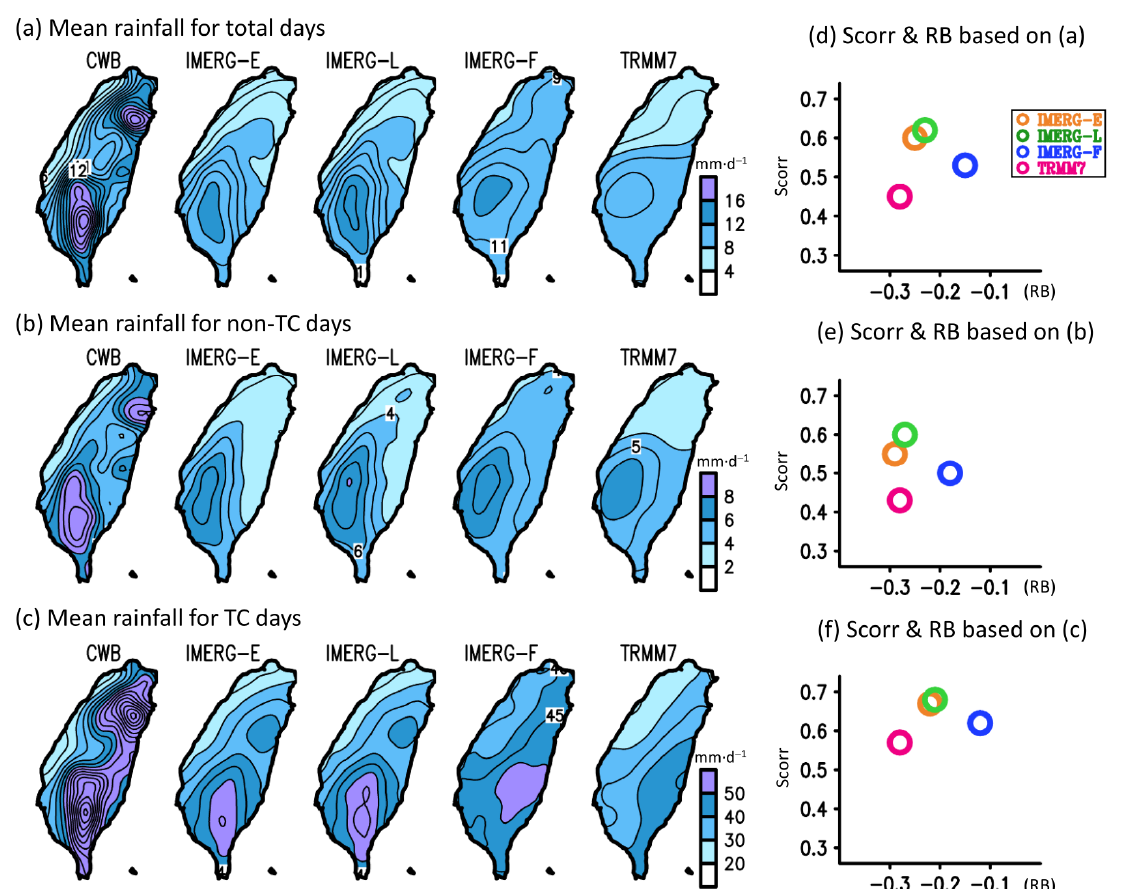
Figure 2. Horizontal distribution of seasonal mean rainfall averaged from ( a ) total days, ( b ) non-TC days, and ( c ) TC days during 2000 – 2018 July to October (JASO) for the CWB and four SPPs (including IMERG-E, IMERG-L, IMERG-F, and TRMM7). ( d – f ) show the spatial correlation (Scorr) and the relative bias (RB) for the comparison between CWB and SPPs in ( a – c ), respectively.